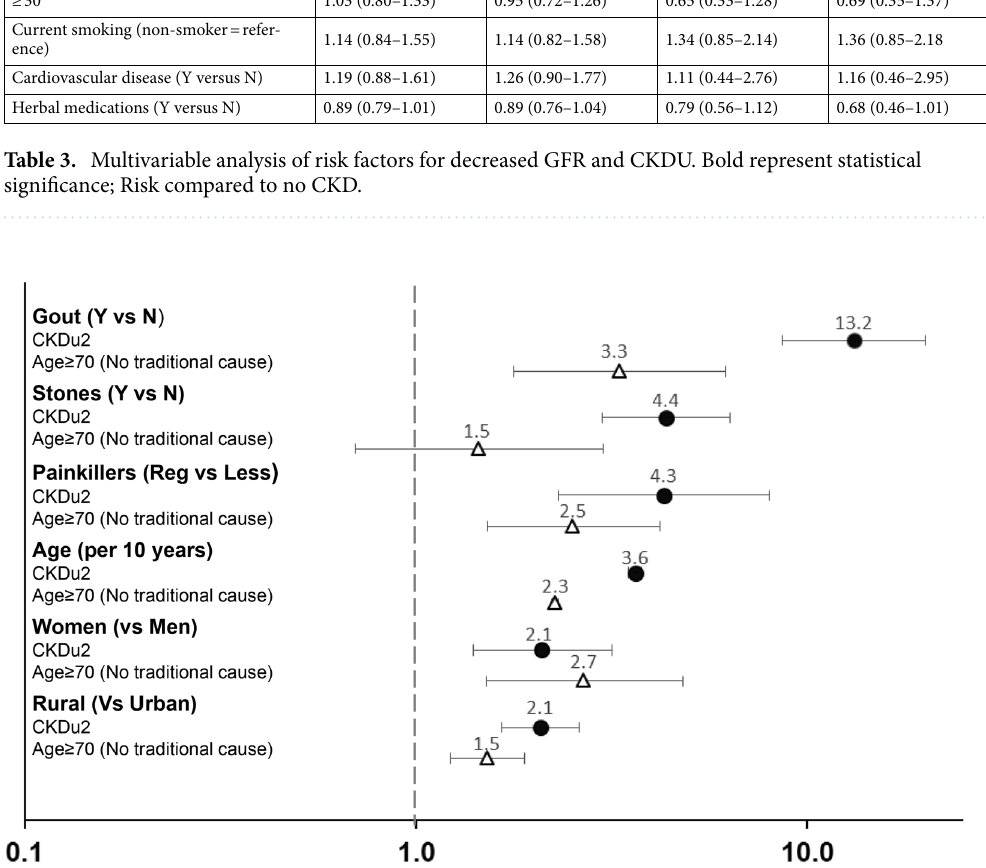
Figure 3. Odds ratio and 95% confidence interval for significant multivariable adjusted risk factors for CKDu2 and elderly subjects with decreased GFR without traditional causes. Odds ratios were calculated separately for CKDu2 (black circle) and subjects age ≥ 70 with decreased GFR without diabetes, hypertension or heavy proteinuria (white triangle). 95% Confidence interval shown as horizontal